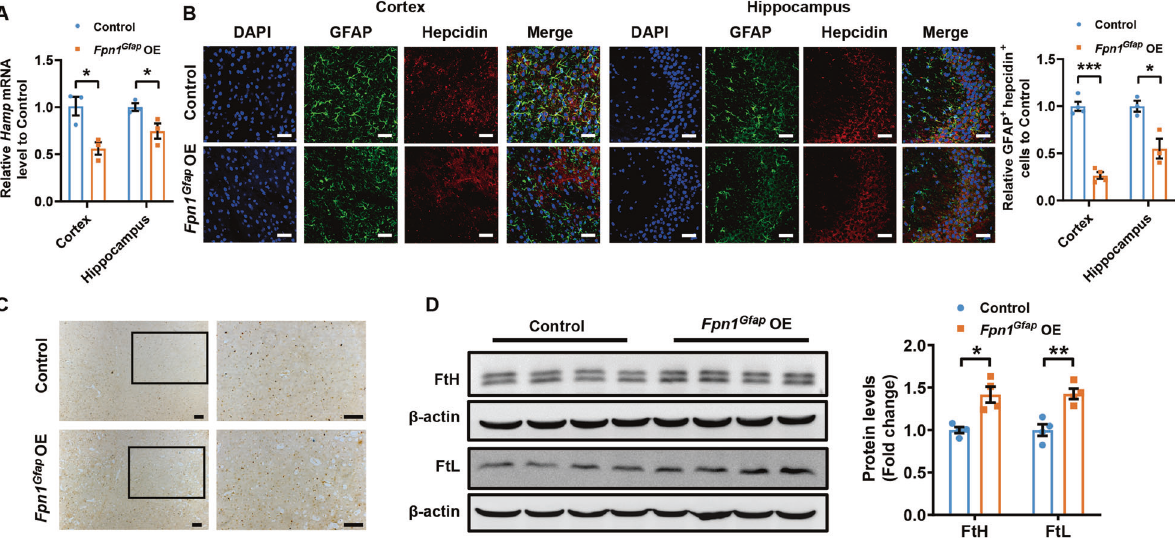
Fig. 5 Overexpression of FPN1 in astrocytes decreased the secretion of astrocyte hepcidin and elevated brain iron. A is the expression of Hamp mRNA detected by qPCR in cortex and hippocampus of 3-month-old control and Fpn1 Gfap OE mice. Values are presented as the mean ± SEM, n = 3, * p < 0.05. B is double immuno fl uorescence labelling of hepcidin (red) and GFAP (green) carried out in control and Fpn1 Gfap OE mice. Scale bar = 40 μ m. The numbers of GFAP and hepcidin-positive cells were counted in fi ve separate fi elds and are presented as a percentage of the total cells in the fi elds. Values are presented as the mean ± SEM, n = 3, * p < 0.05, *** p < 0.001. C is the iron level detected by Perl ’ s iron staining in cortex and hippocampus of control mice and Fpn1 Gfap OE mice. Scale bar = 100 μ m. D are the protein levels of FtL and FtH in cortex. Expression levels were normalized to β -actin and presented as the mean ± SEM. n = 4. * p < 0.05, ** p < 0.01 vs. control